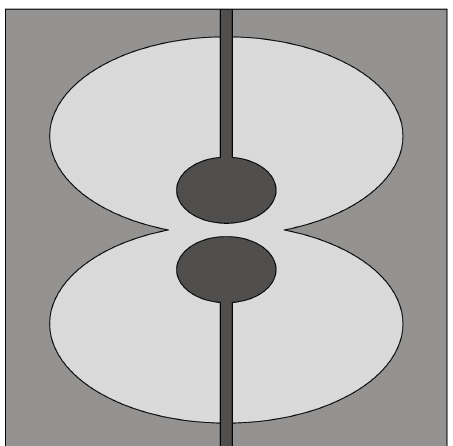
Figure 26. Layout of the double-elliptical slot antenna (redrawn from [100]). Dark gray top metal face, medium gray bottom metal face, and light gray dielectric substrate.